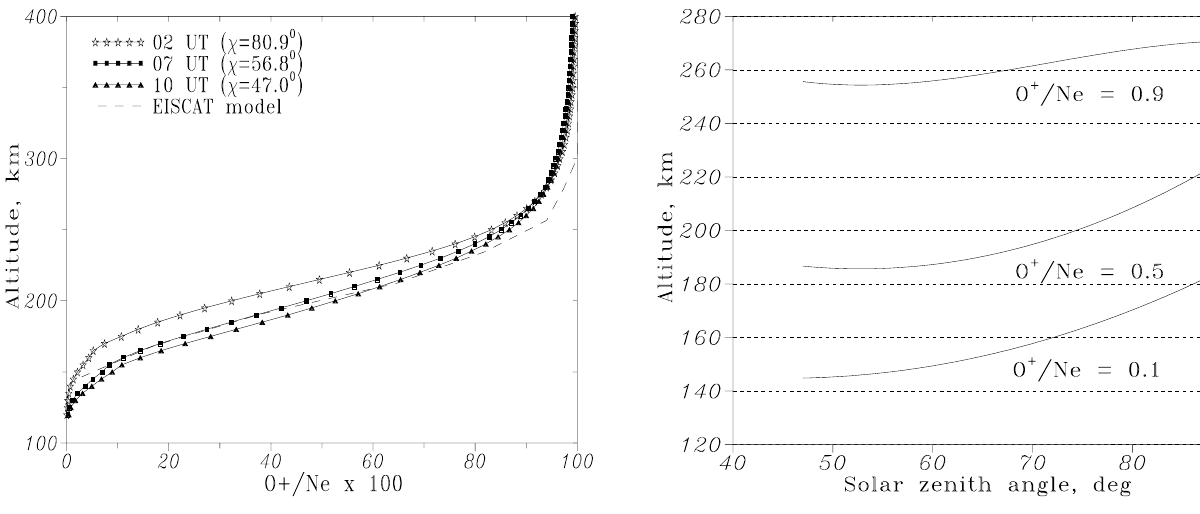
Fig. 5. Calculated variations of the O + /Ne ratio at three levels (10, 50 and 90%) with solar zenith angle. Note the steepness of the variation is decreased at high altitudes (90%